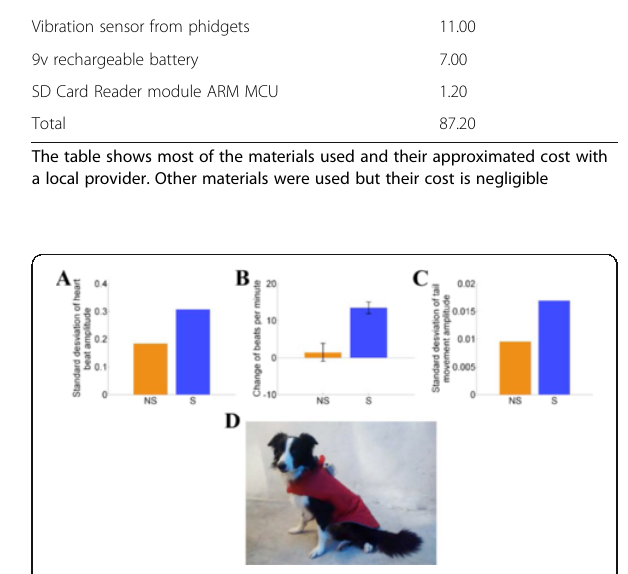
Fig. 11 (abstract A13). The results shown were obtained from two dogs under two consecutive conditions. Stimulation and No- stimulation. In panels a , b and c , the colors represent the conditions. The panel a represents the standard deviation from the mean of the heart beat amplitude. The panel b represents the change on the beats per minute on both conditions minus a baseline registered directly from each dog. The vertical lines represent the standard error. The panel c represents the standard deviation from the mean of the tail movement. The panel d shows one of the registered dogs wearing the